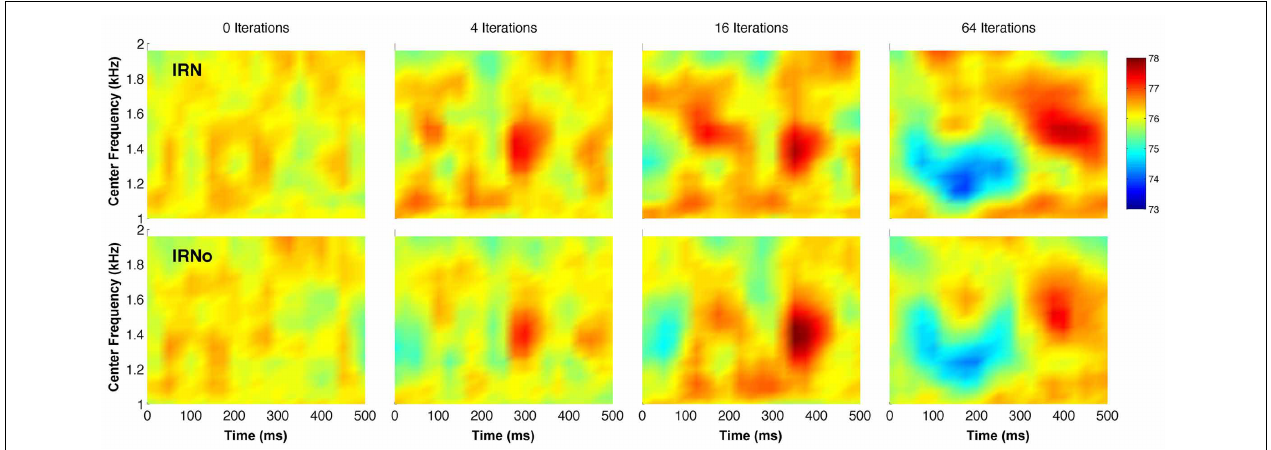
FIGURE 1 | Simulated cochlear representations of IRN (top row) and IRNo (bottom row) in the form of spectrograms. The number of delay and add iterations increases from left to right. The analysis smoothes the representation in both time and frequency domains to remove any fine